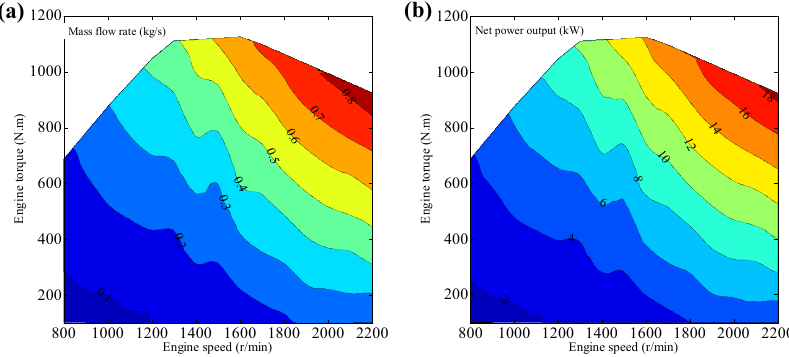
Figure 11. ( a ) The working fluid mass flow rate of the LT cycle; ( b ) The net power output of the LT cycle.